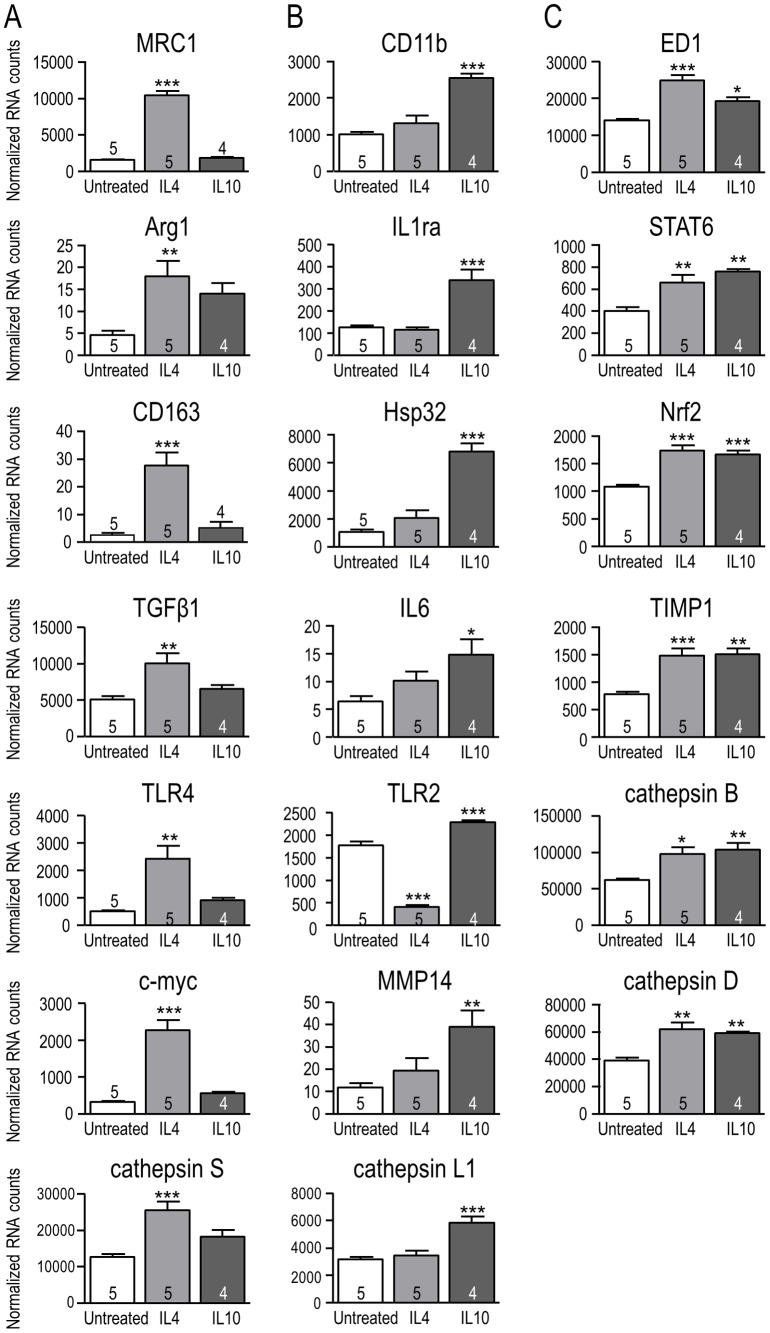
NanoString analysis of expression changes for selected genes in response to IL4- and IL10-treatment.Treating rat primary microglia for 6 hr with 20 ng/ml IL4 or 20 ng/ml IL10 resulted in gene expression changes that were specific for IL4 (A), specific for IL10 (B), or common to both treatments (C). mRNA expression was normalized to the housekeeping gene, HPRT1, and shown as mean ± SEM with the number of individual cultures indicated on each bar. [Note the differing Y-axis scales.] One-way ANOVA with Tukey's post-hoc test revealed differences from unstimulated (control) microglia: *p<0.05, **p<0.01, ***p<0.001.